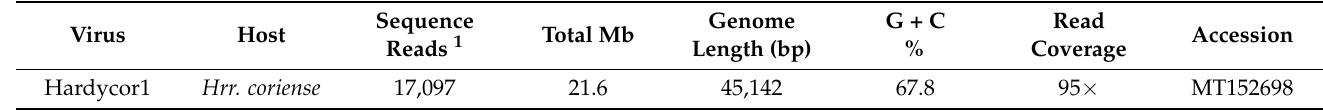
Table 1. Sequencing details for Hardycor1.